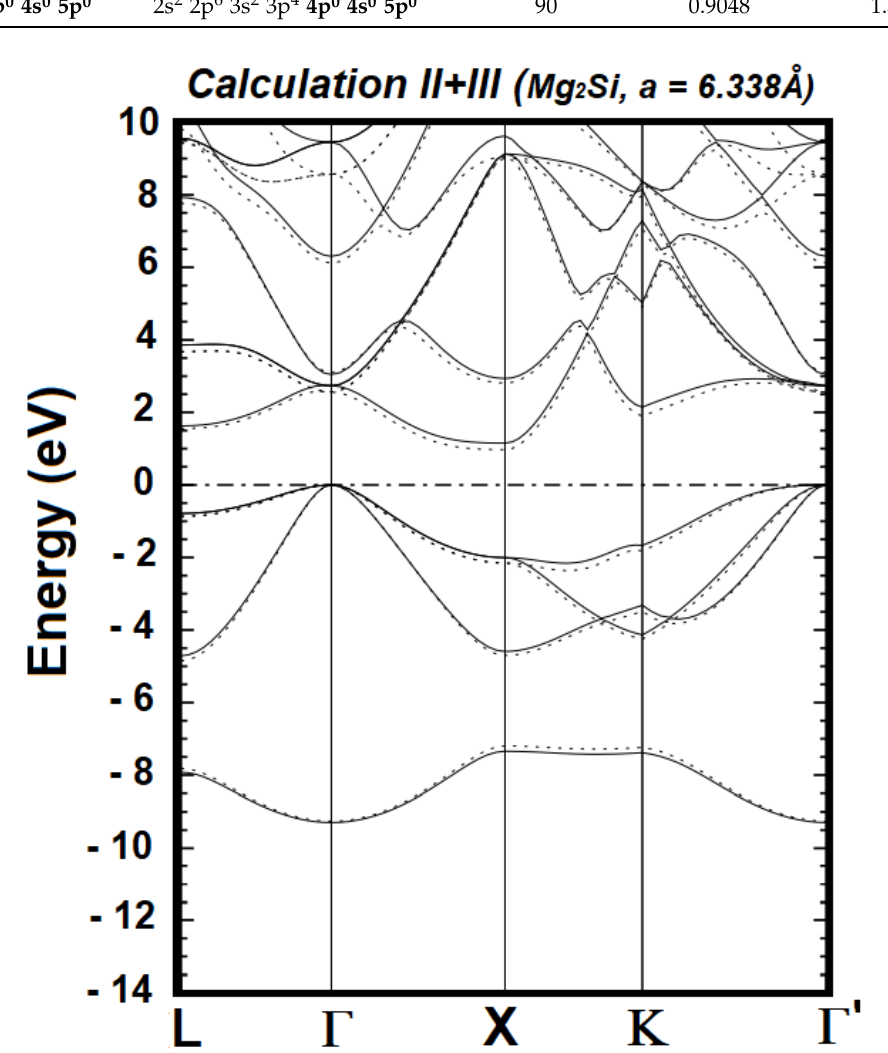
Figure 1. Electronic energy bands of cubic Mg 2 Si from Calculation II (solid lines) and Calculation III (dotted lines), upon setting the Fermi level to zero; this level is indicated by the horizontal dashed-dotted line.